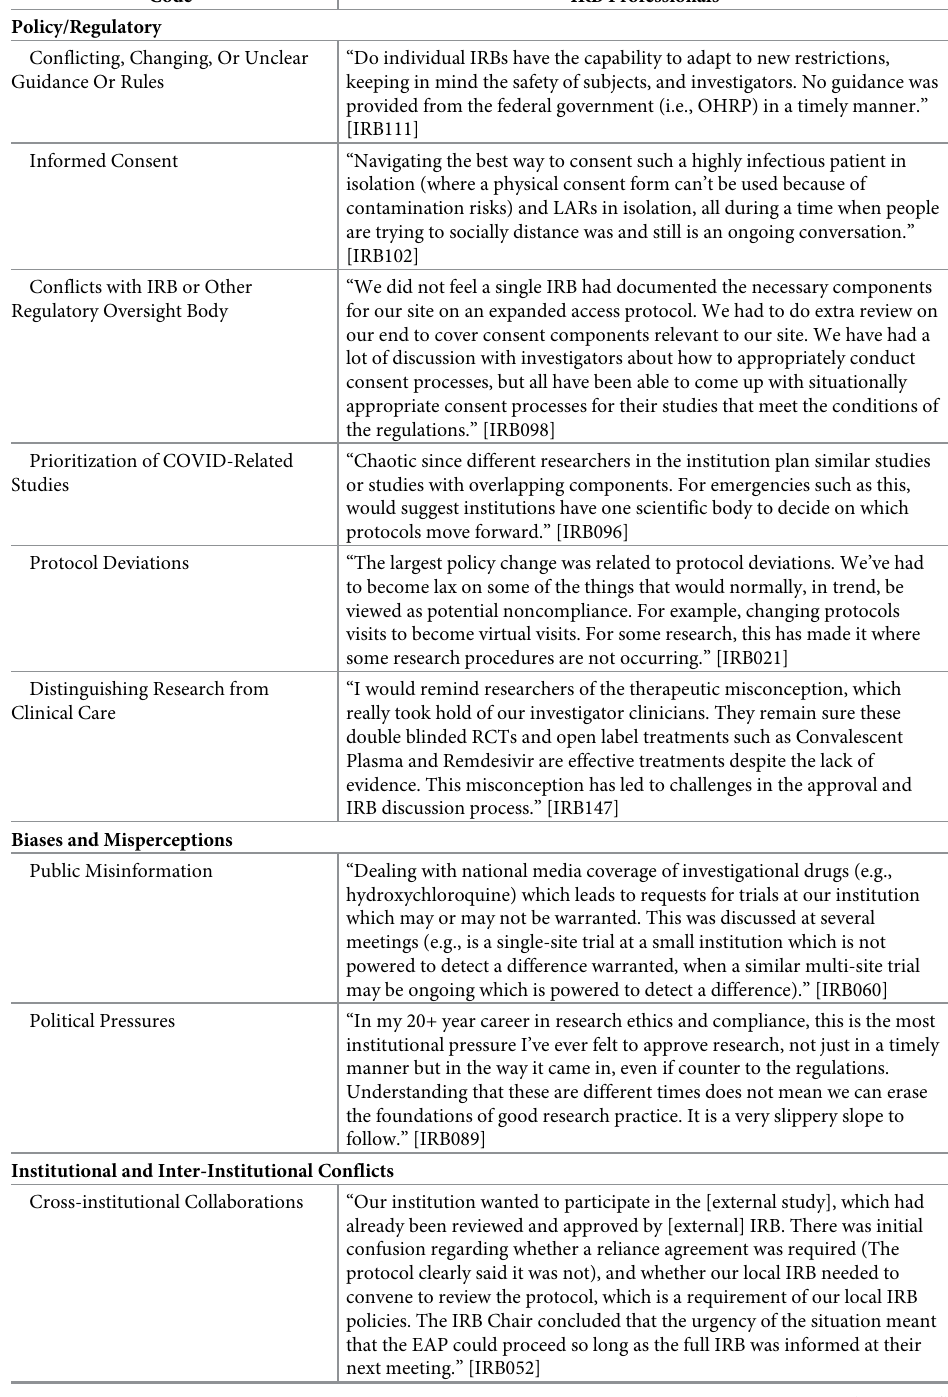
Table 4. Barriers to research—IRB professional